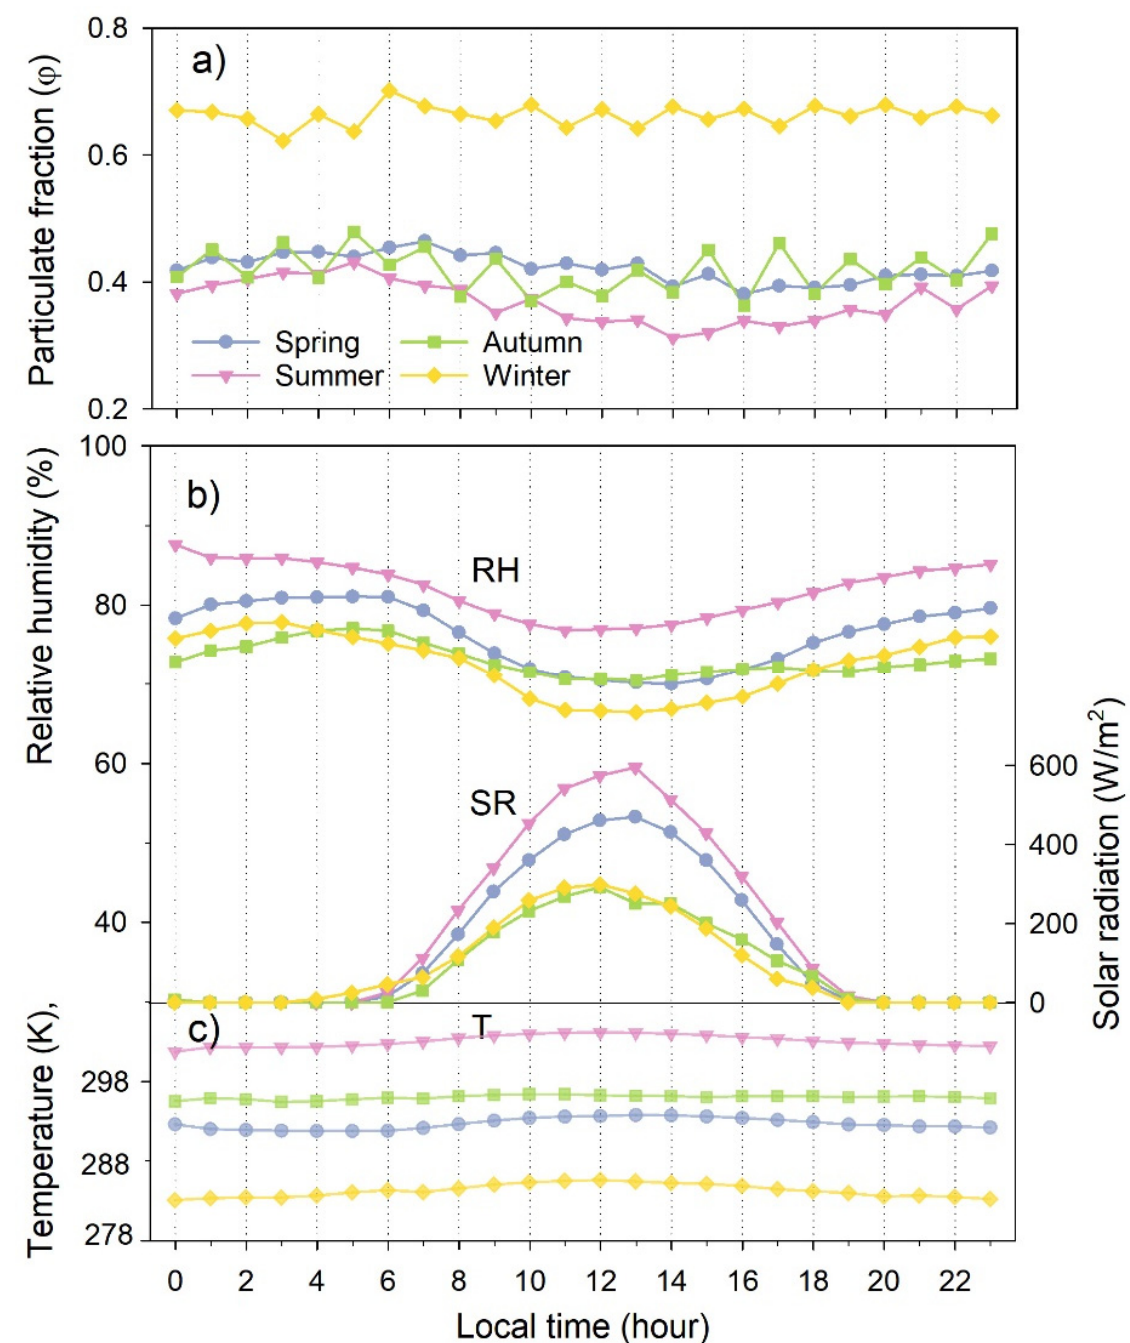
Figure 5. The diurnal variations in φ , temperature, relative humidity and solar radiation.